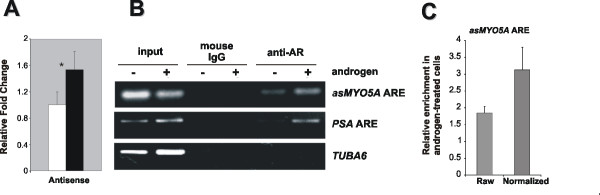
Increased levels of antisense intronic MYO5A transcript correlates to binding of androgen receptor to a putative upstream androgen response element. (A) Expression level of antisense intronic transcript of MYO5A was measured in androgen-treated (black bars) or untreated control (white bars) cells. Relative fold change (Y axis) shows the increase or decrease in transcript levels after androgen treatment relative to their levels in untreated control cells. Error bars refer to standard deviations relative to mean fold-change values. Differential expression of antisense MYO5A transcripts was statistically significant (p < 0.05) as indicated by asterisks. (B) Cellular lysates from androgen-treated (+) or control cells (-) were used in chromatin immunoprecipitation (ChIP) assays in the presence of an antibody reactive with the androgen receptor protein (anti-AR). PCR reactions were used for detection of immunoprecipitated DNA containing an androgen response element (ARE) located upstream to the MYO5A antisense intronic transcript (asMYO5A ARE) in androgen-treated (+) or untreated control cells (-). Prostate-specific antigen ARE (PSA ARE), or a non-related genomic sequence upstream of the tubulin α6 gene (TUBA6) were used as positive and negative PCR controls, respectively. An unrelated antibody (mouse IgG) was used as a control for nonspecific immunoprecipitation. Equal volumes of lysates from androgen-treated or control cells (1:100 of total lysate) were treated in parallel, and used as loading controls of input DNA for each ChIP assay (input). (C) Enrichment ratios of asMYO5A ARE bound to AR in androgen-treated cells relative to control cells. Enrichment ratios (Raw) represent mean ratio values calculated from the integrated band intensities obtained at two different PCR cycle numbers (25 and 30 cycles), in reactions similar to those of Figure 4B, as described in Methods. Band intensities from input DNA were used to obtain normalized enrichment ratios (normalized). Error bars show the standard deviation of mean ratios.